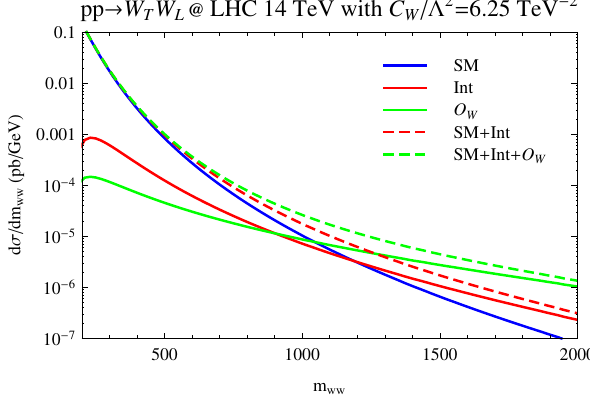
Figure 3. Invariant mass distributions for the production of one longitudinally polarized W boson and one transversely polarized W boson with the same color convention as in Fig. 2.